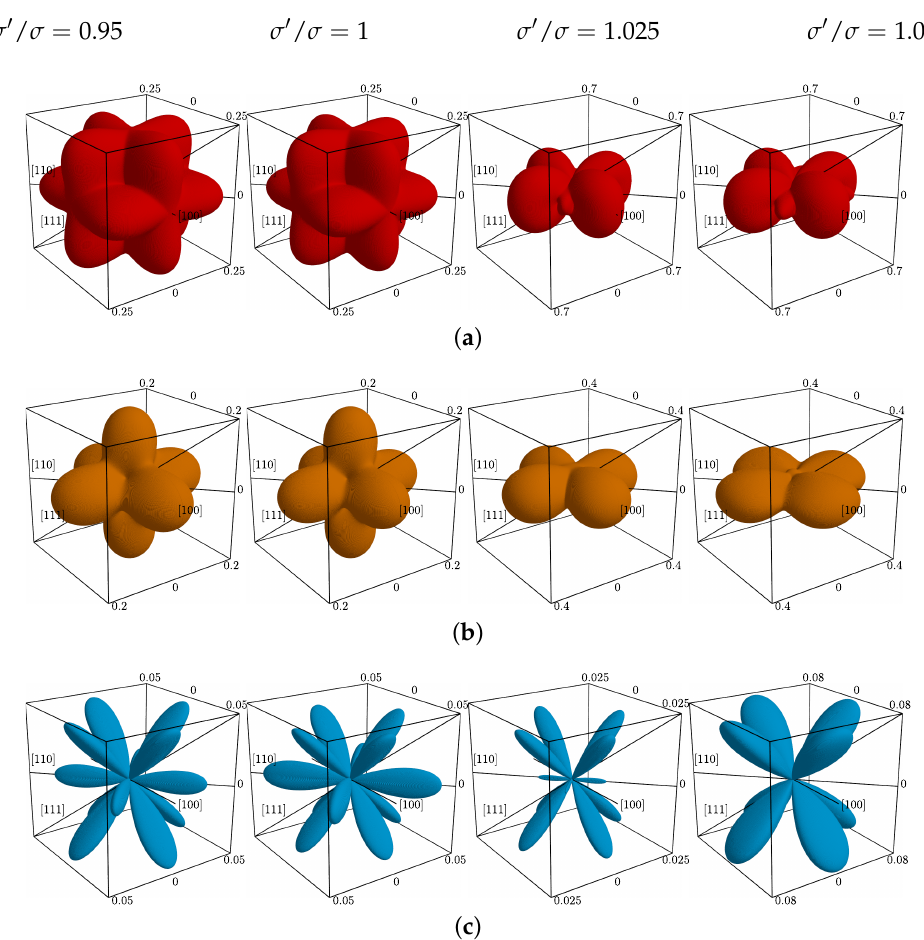
Figure 6. The array of plots of the Poisson’s ratio for selected values of σ (cid:48) / σ ratio (in respective columns). The rows contain: ( a ) maximal PR, ( b ) average PR, and ( c ) negative part of the minimal Poisson’s ratio in (cid:126) n -directions. For each plot, the infinite set of possible (cid:126) n -direction has been uniformly sampled in 5 10 5 distinct ×